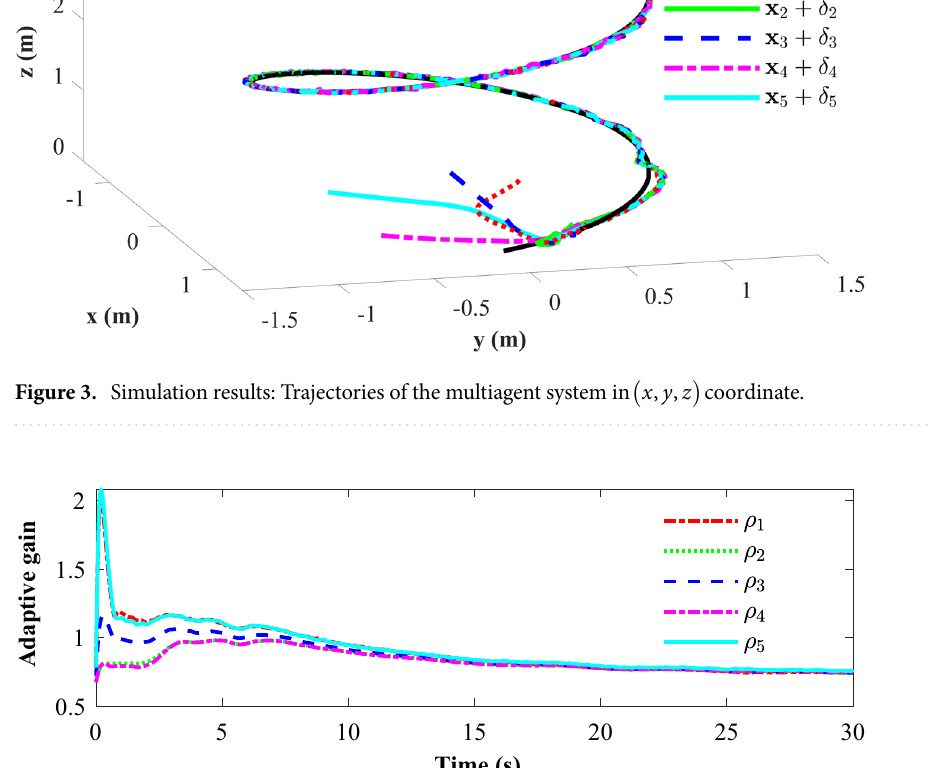
Figure 4. Simulation results: The adaptive switching gain for different agnets.